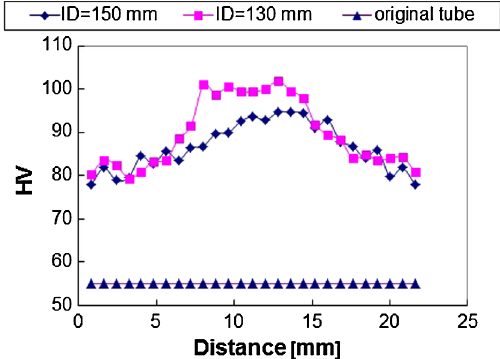
FIG. 21. Vickers hardness HV along the cell contour — starting from the iris. Cells are hydroformed from tubes of ID ¼ 130 mm and ID ¼ 150 mm. Straight line represents the HV of the original tube.